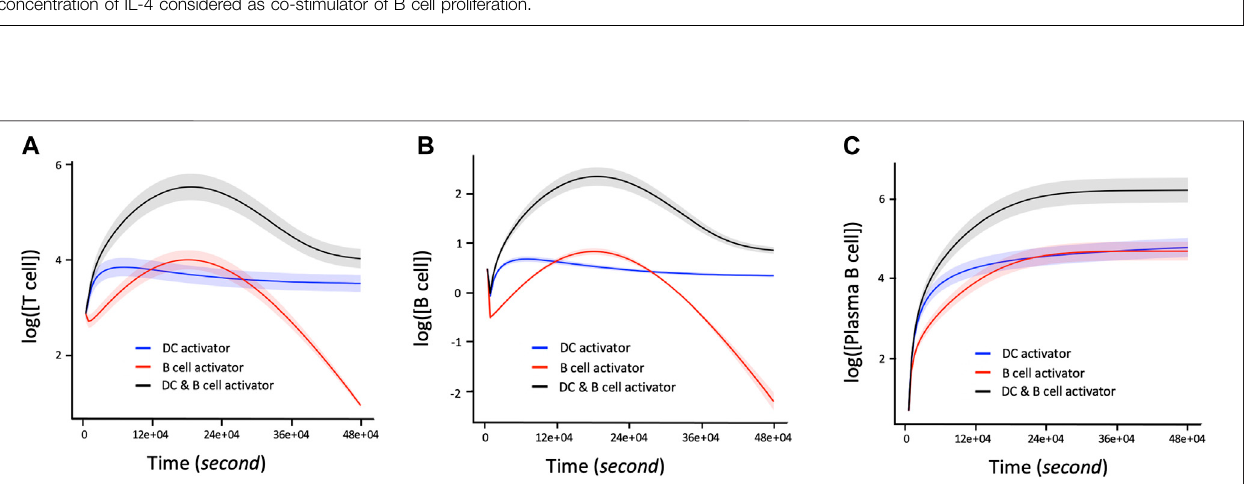
Frontiers in Molecular Biosciences |